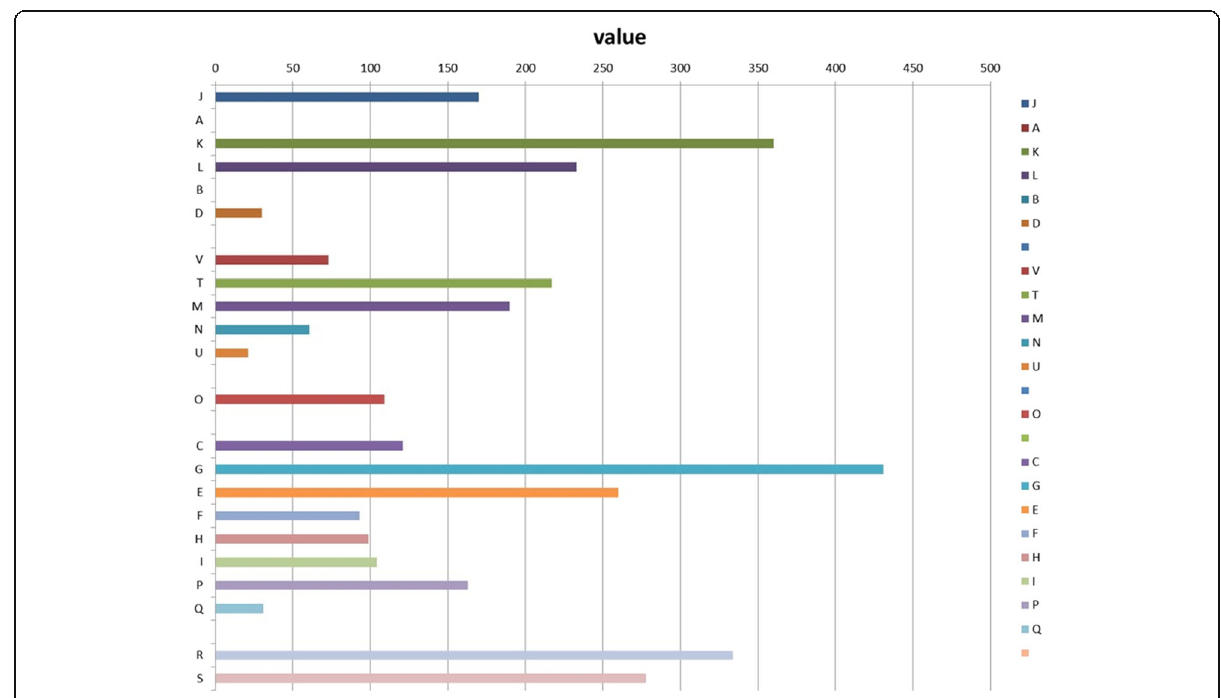
Fig. 3 COG analysis of strain DCY84